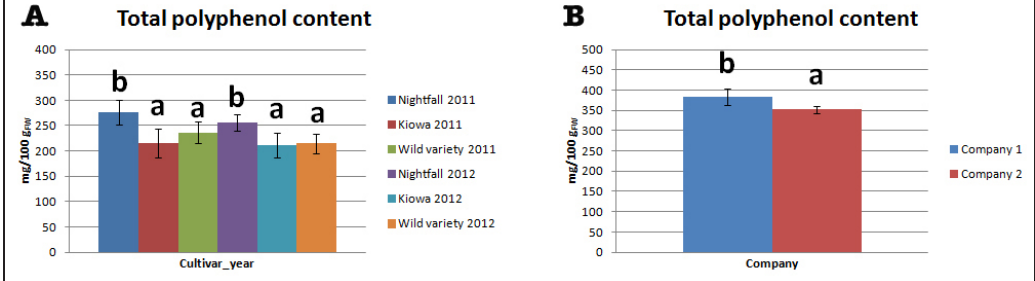
Fig. 3: Rubus ulmifolius : TPC in University bud-preparations (A) and Company bud-preparations (B). Different letters for each sample indicate the significant differences at